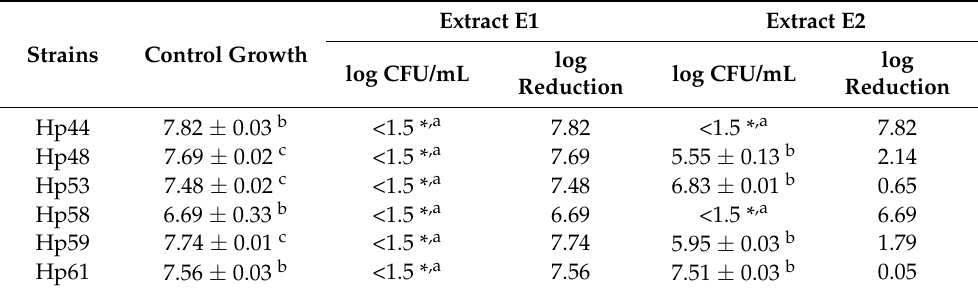
Extract E1 Extract E2 log log log CFU/mL log CFU/mL Reduction Reduction